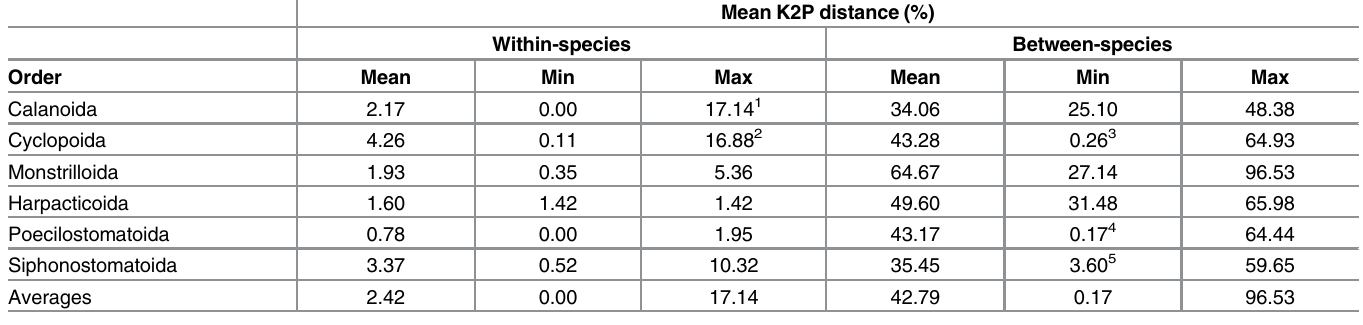
Table 4. Mean Kimura-2-parameter (K2P) distances within species and between species estimated from nucleotide sequences of COI for 133 indi- viduals of 94 copepod species along the six different orders.